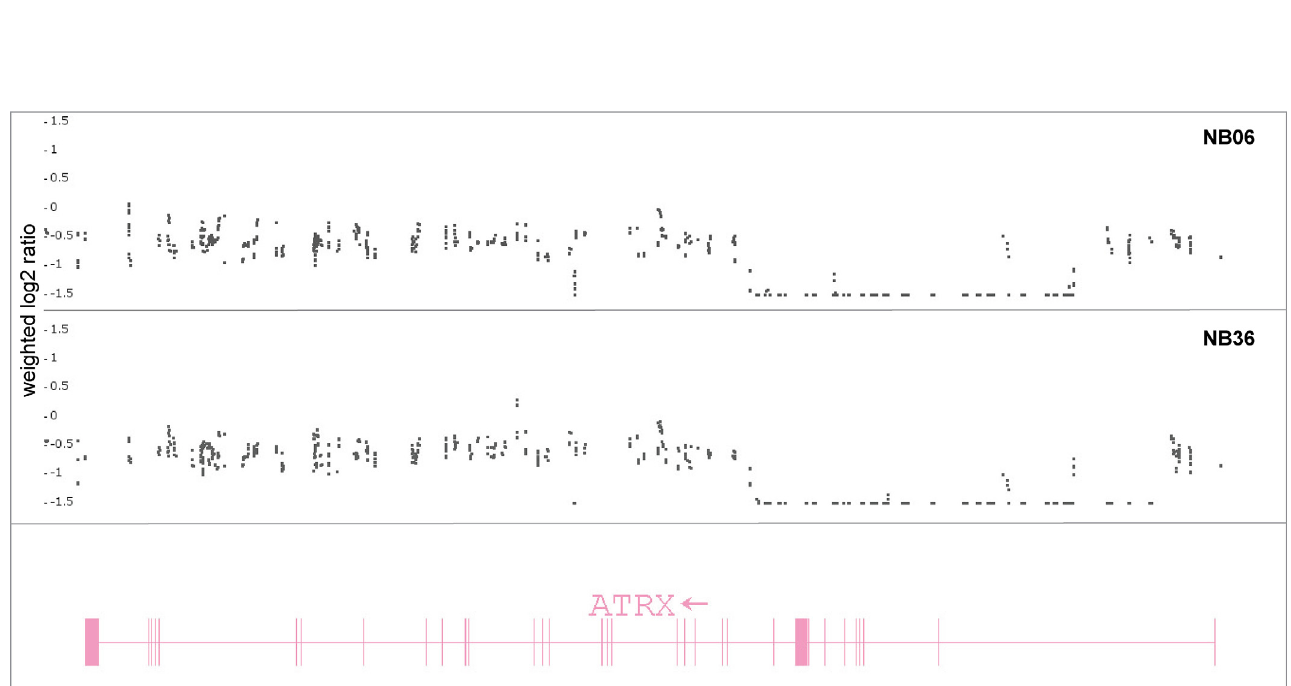
Fig 6. Partial ATRX nullisomy in NB samples NB06 and NB36. Exons 2 – 10 of the ATRX gene (transcript variant 1; NCBI RefSeq accession number NM_000489) are deleted in both NB samples (NB06 upper panel, NB36 middle panel). The proximal breakpoints are located at the same chromosomal position in both samples (76,925 kb), however, the lengths of the deletion differed in both samples (~ 80 kb for NB06 and ~ 100 kb for NB36). The lower track shows the spatial assembly of the ATRX gene, the exons are indicated by vertical lines or blocks.